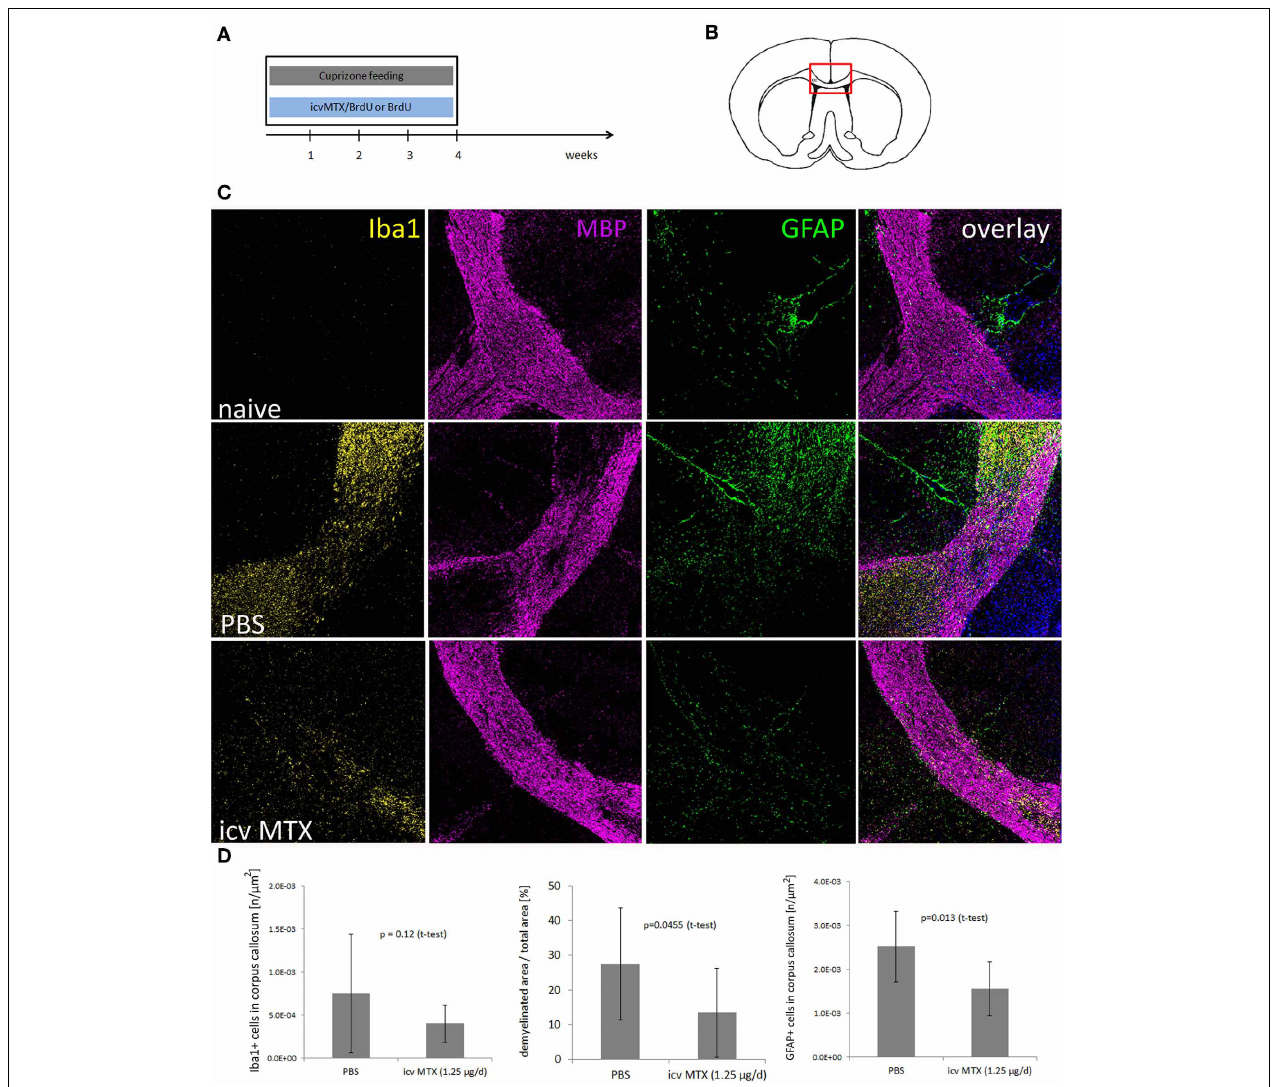
FIGURE 2 | icv MTX administration modulates Cuprizone-induced demyelination and astroglial activation. (A,B) Eight mice per group were fed with cuprizone and received either 1.25 µ g/day methotrexate dissolved in 10mg/mL BrdU/PBS intracerebroventricularly or just 10mg/mL BrdU in PBS. After 4 weeks animals were sacrificed and the midline of the corpus callosum was analyzed for pathological differences. (C)